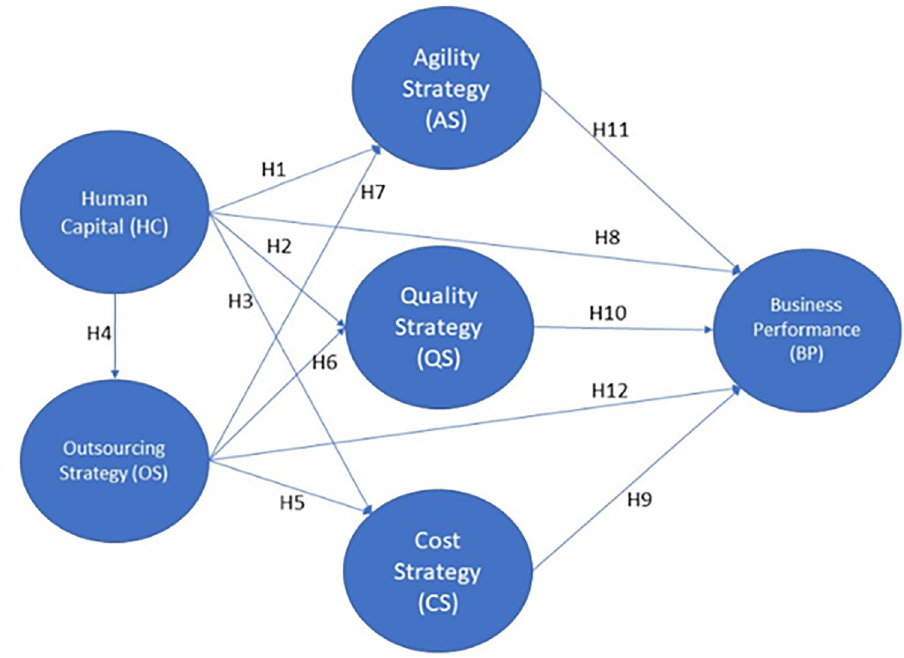
Fig 1. Research model with